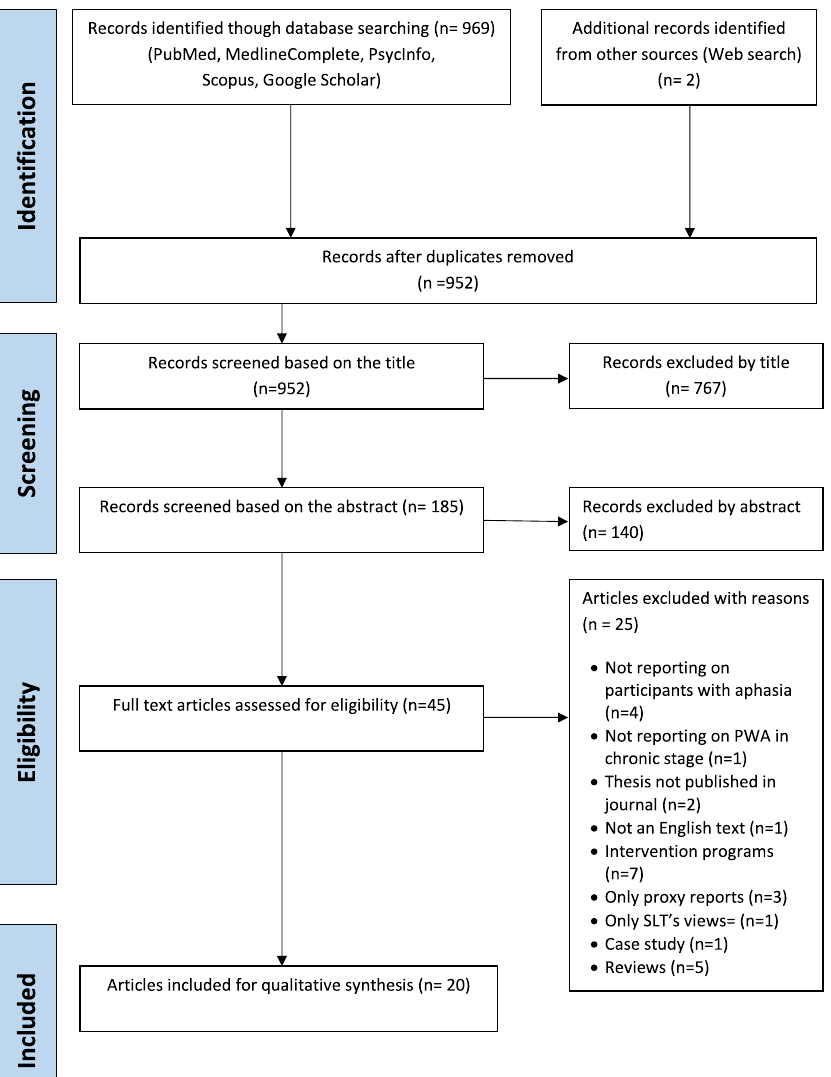
Figure 1. PRISMA flow diagram for the scoping review